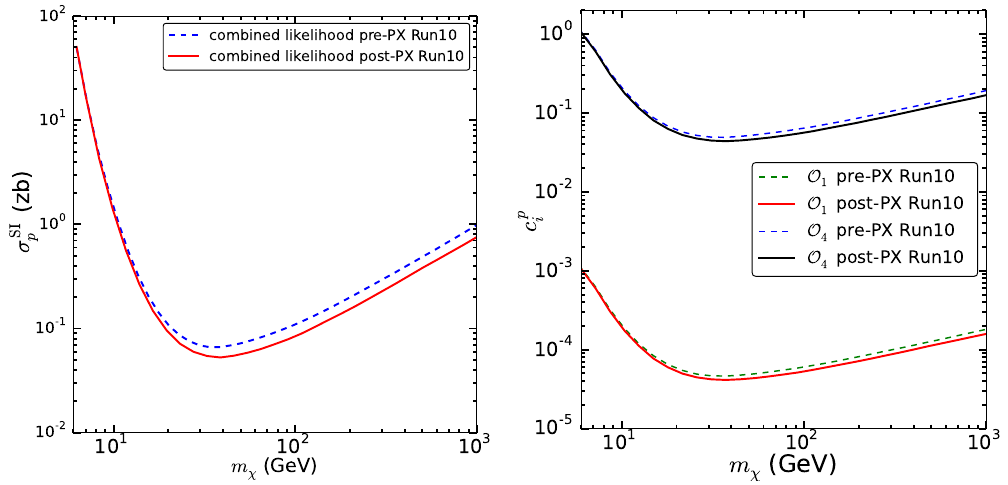
for new combined likelihood (red solid line) p for O 1 i